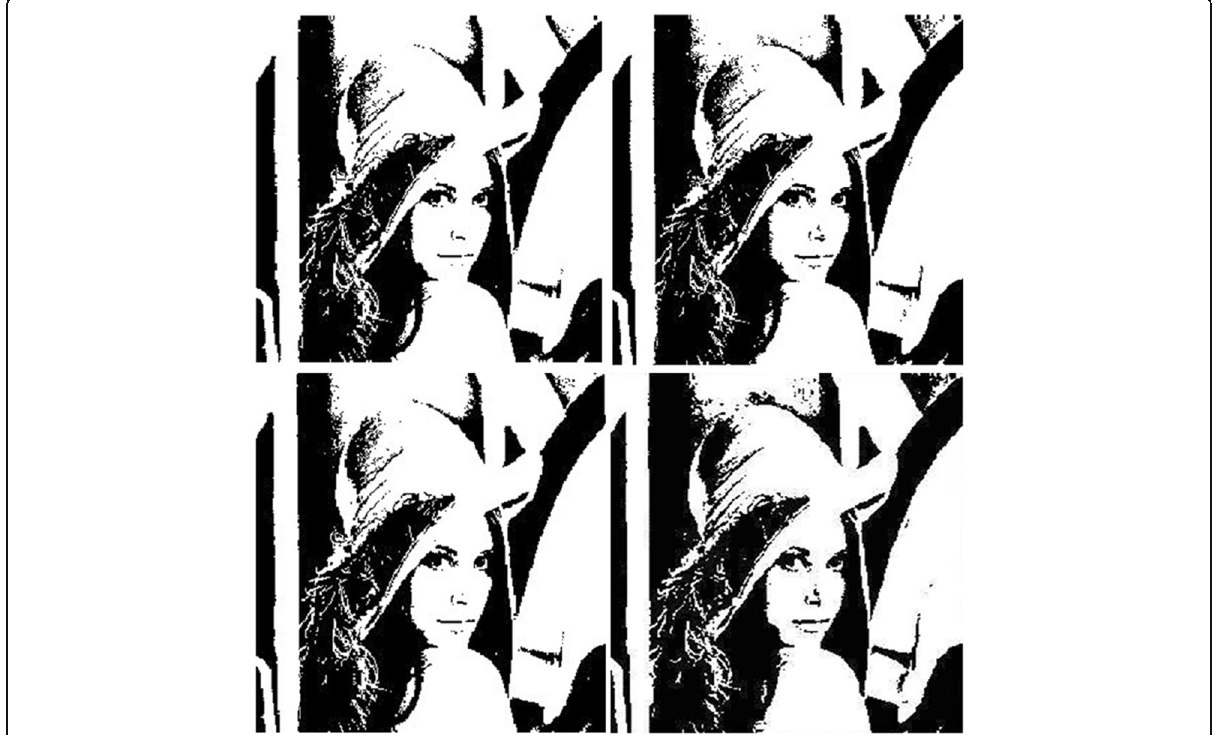
Fig. 5 Lena image segmentation results (the upper left is the proposed method, the upper right is the FCM method, the lower left is K-means method, and the lower right is the KFCM